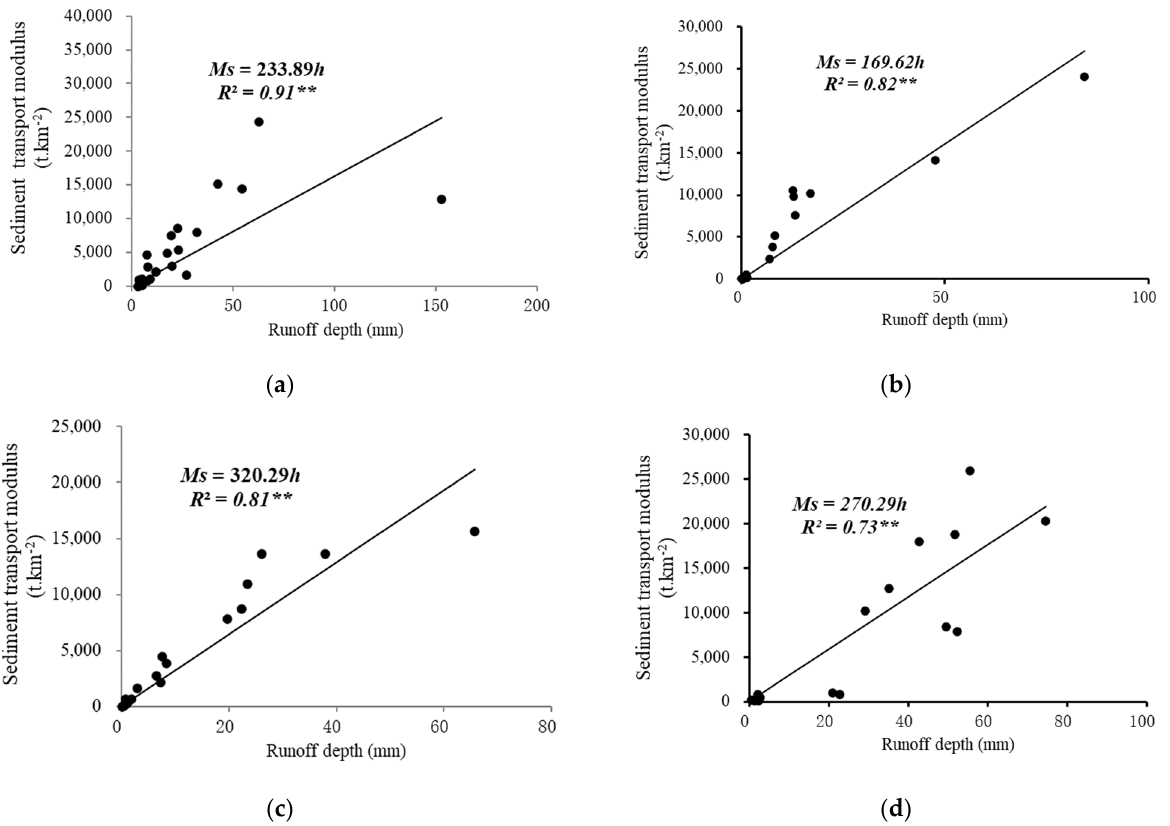
Figure 2. Relationships between runoff depth and sediment transport modulus of the different geomorphic units on annual scale. ( a ) Peijiamao watershed; ( b ) Qiaogou gully; ( c ) first branch of Qiaogou gully (subgully); ( d ) whole slope. Note: ** significance at the 0.01 level; n =